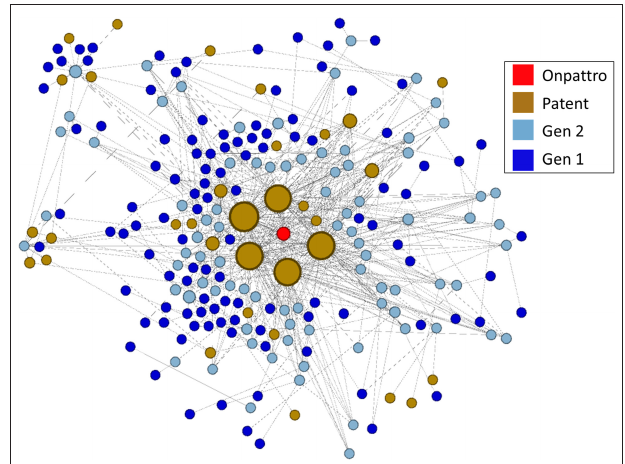
FIGURE 9 | Patents and publications in the Onpattro cluster. Seven patents are associated with Onpattro in the FDA Orange book. The cluster also contains seven additional patents not related to